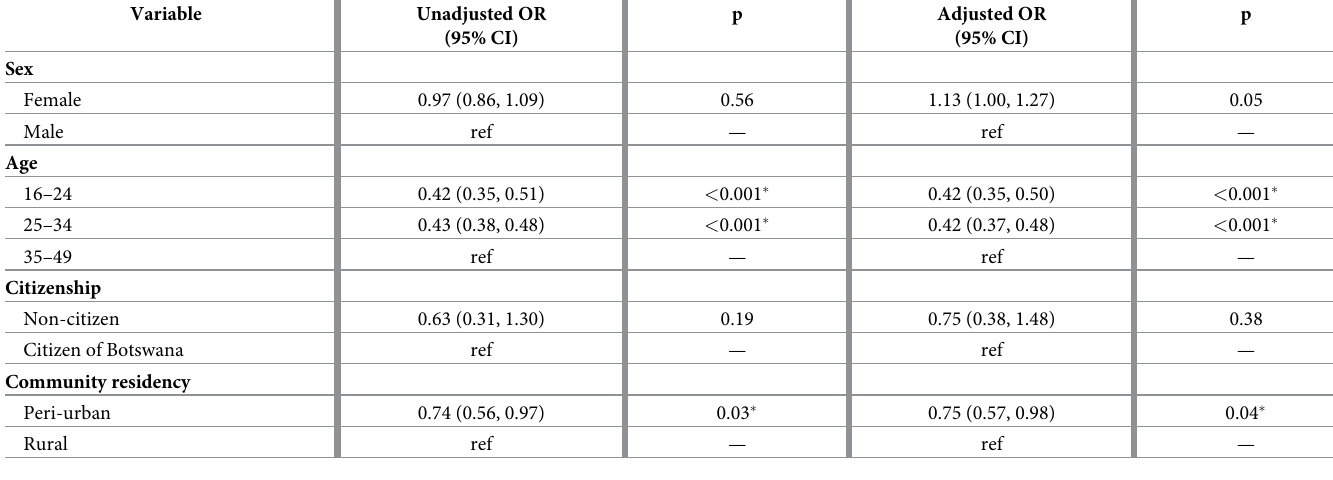
Table 5. Association of sociodemographic variables to ART use among persons who had prior knowledge of HIV-positive status, n = 9,743.